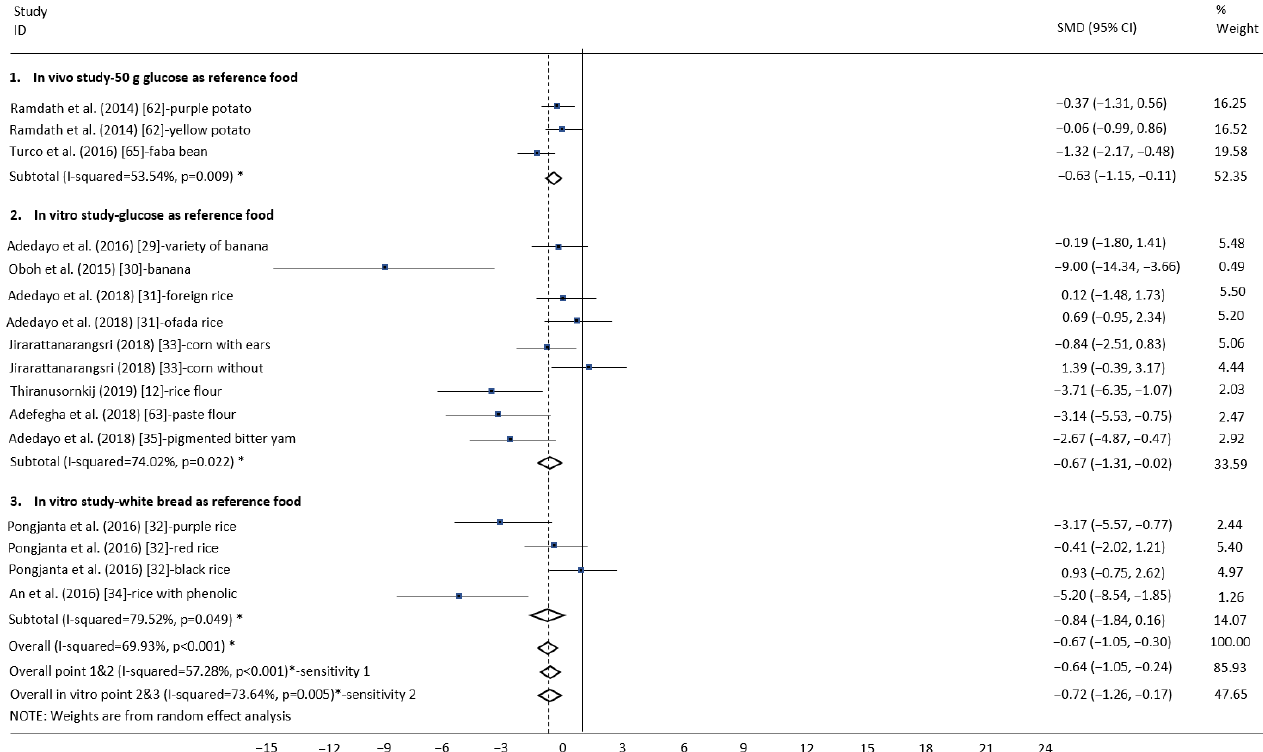
Figure 6. Subgroup analysis of the glycemic index according to the differing phenolic content in carbohydrate foods. Standardized mean difference (SMD), confidence interval (CI), and point represent the estimated overall effect size (with 95%CIs) for each study. Positive values indicate relatively higher phenolic content in carbohydrate foods. Negative values indicate relatively lower phenolic content in carbohydrate foods.